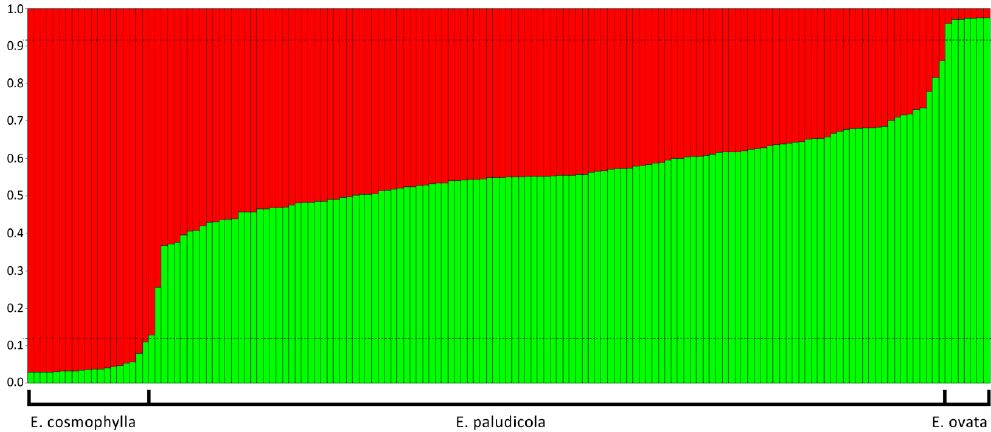
Figure 1. Proportion of ancestry for 151 Eucalyptus individuals with K = 2, inferred using STRUCTURE. Red and the green clusters correspond to E. cosmophylla and E. ovata, respectively, while E. paludicola shows admixture. The horizontal dashed lines indicate the range of Q values for simulated hybrid individuals (see text for details).